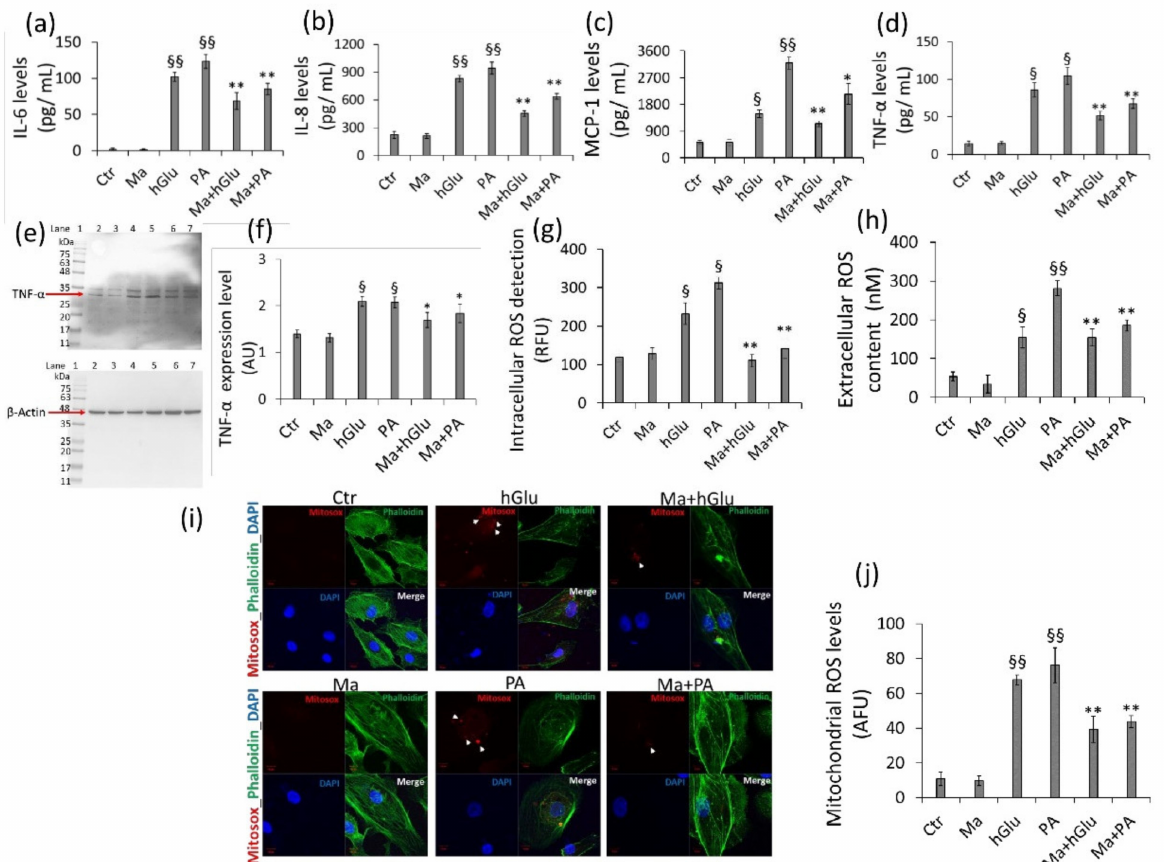
Figure 3. Antioxidant and anti-inflammatory activities of Magliocco. Endothelial cells were exposed to Magliocco (Ma), high glucose (hGlu) (30 mM), palmitic acid (PA) (0.5 mM), or combined Ma+hGlu and Ma+PA for 48 h. ( a – d ) IL-6, IL-8, MCP-1, and TNF- α -level measurements. ( e – f ) TNF- α protein expression. Lane 1 = protein ladder molecular weight markers, lane 2 = Ctr, lane 3 = Ma, lane 4 = hGlu, lane 5 = PA, lane 6 = Ma+hGlu, and lane 7 = Ma+PA. The analysis of densitometric intensity was calculated with ImageJ software and expressed as arbitrary units (AU) ± SD of n = 4 replicates. β -Actin was used as internal control. ( g ) Intracellular and ( h ) extracellular ROS content evaluations. ( i ) Representative images of confocal laser scanning analyses of mitochondrial ROS generation (indicated with white arrows) detected by MitoSOX probe and ( j ) mitochondrial superoxide level assessment. The results are expressed as arbitrary fluorescence units (AFU) ± SD of n = 3 replicates. Scale bars = 10 µ m. The cytoskeleton is marked with Phalloidin 488 (green), while DAPI was used as a nuclei counterstain (blue). § p < 0.01 vs. Ctr, §§ p < 0.001 vs. Ctr, * p < 0.05 vs. hGlu or PA, and ** p < 0.01 vs. hGlu or